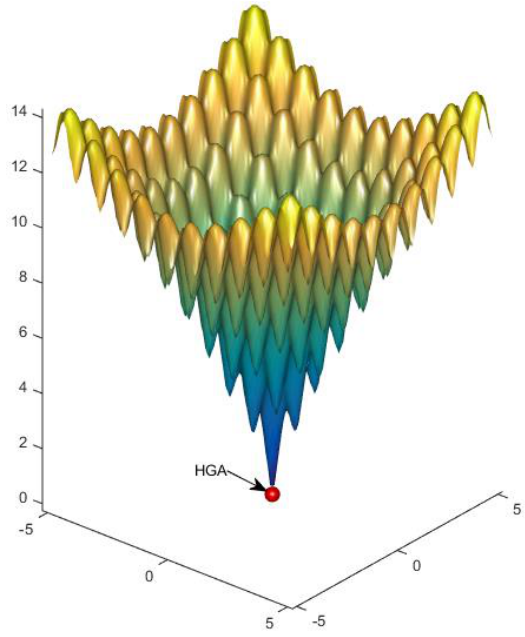
Figure 4. Ackley benchmark function with two independent variables and n = 2, a = 20, b = 0.2, c = 2π.